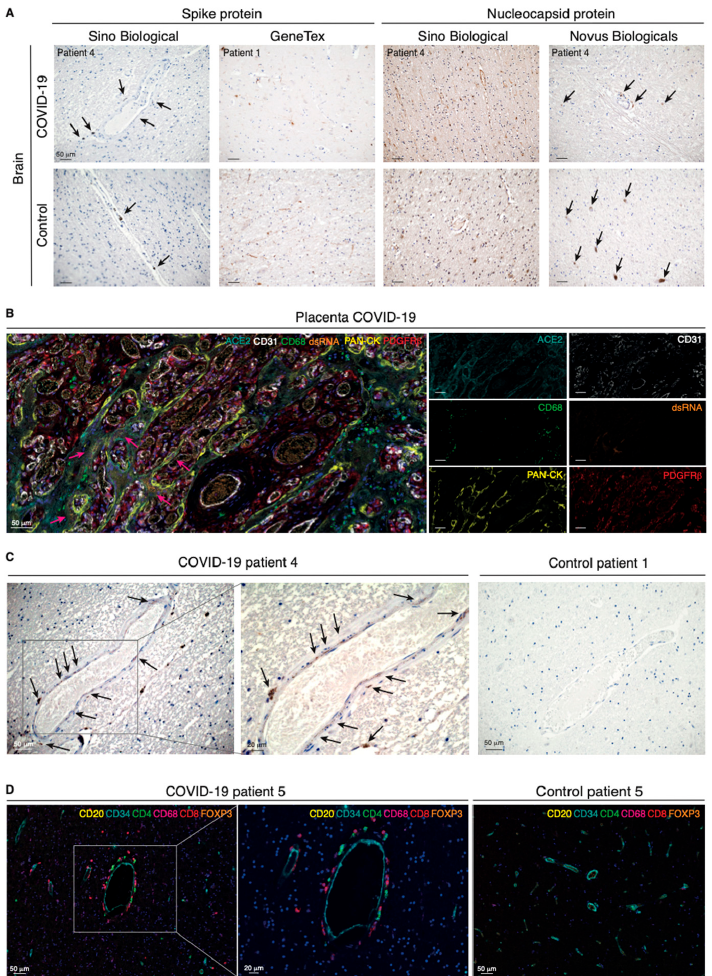
Figure 2. Perivascular infection by SARS-CoV-2 is paralleled by perivascular inflammation in the brain of COVID-19 patients. ( A ) Immunohistochemical detection of viral components in